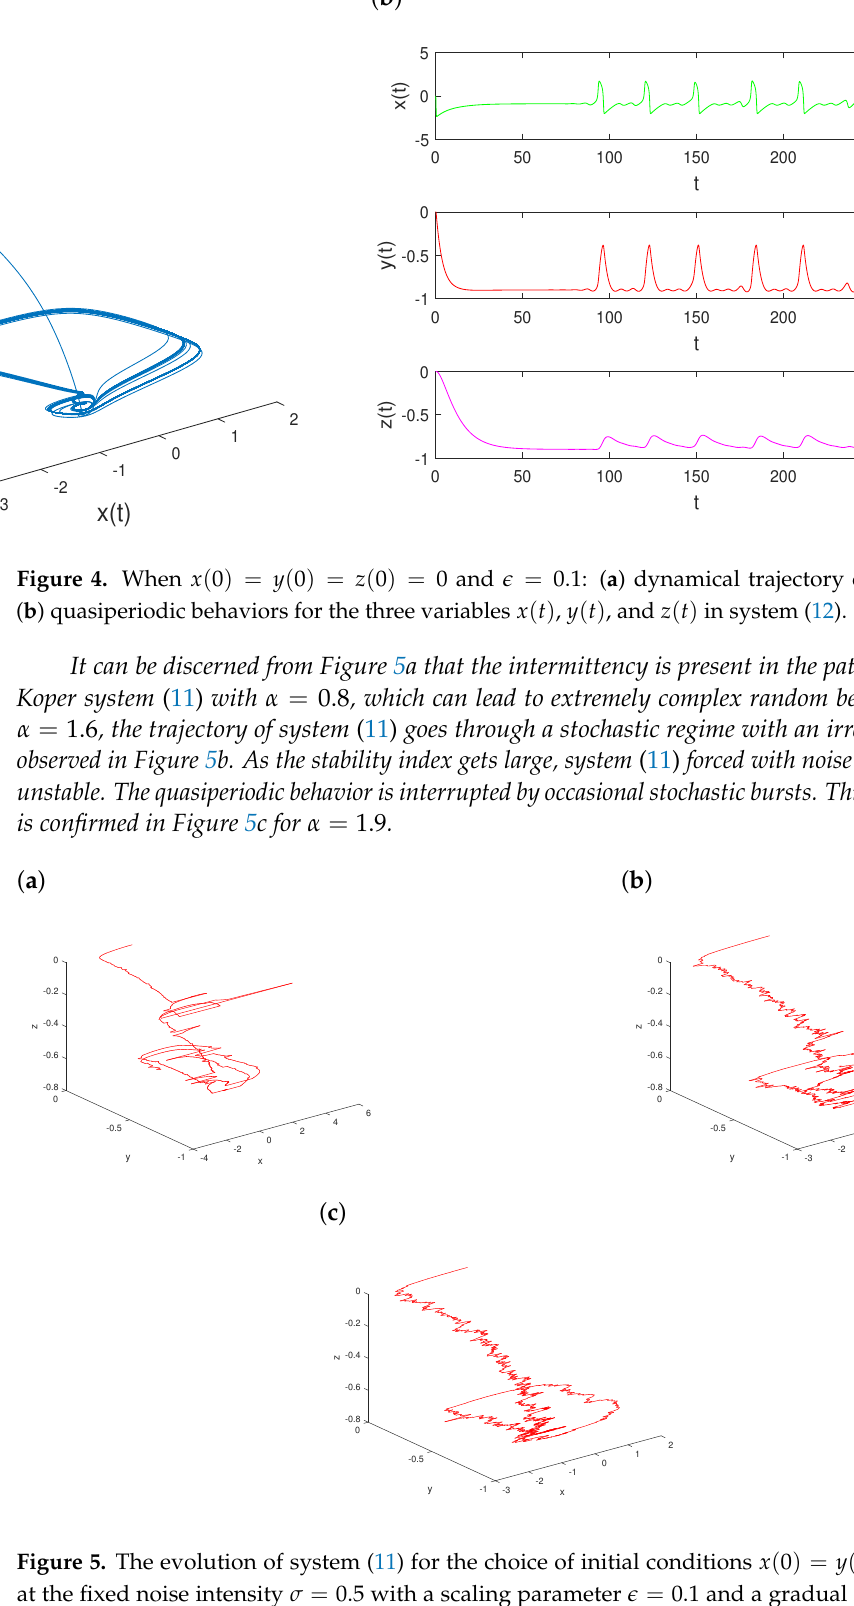
Figure 5. The evolution of system (11) for the choice of initial conditions x ( 0 ) = y ( 0 ) = z ( 0 ) = 0 at the fixed noise intensity σ = 0.5 with a scaling parameter (cid:101) = 0.1 and a gradual increase in the stability index: ( a ) α = 0.8; ( b ) α = 1.6; ( c ) α =